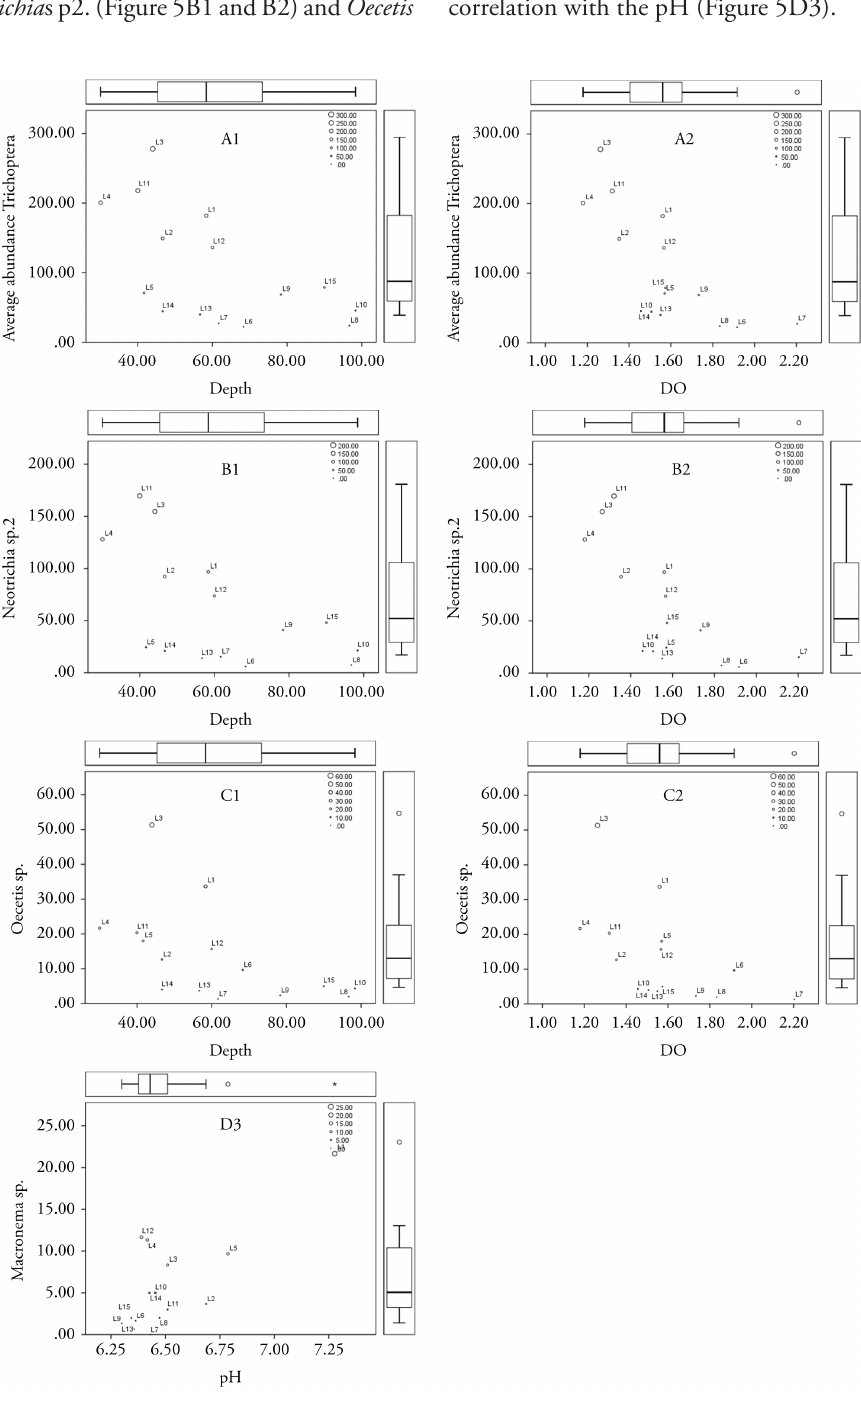
Figure 5. Distribution of the average abundance of Trichoptera (A) and average abundance of genera Neotrichia (B), Oecetis (C) and Macronema (D) associated to E. crassipes in the gradient of depth (1), dissolved oxygen (2) and pH (3) of the in the 15 marginal lakes along the Paraguay River, MT, sampled in September 2005.